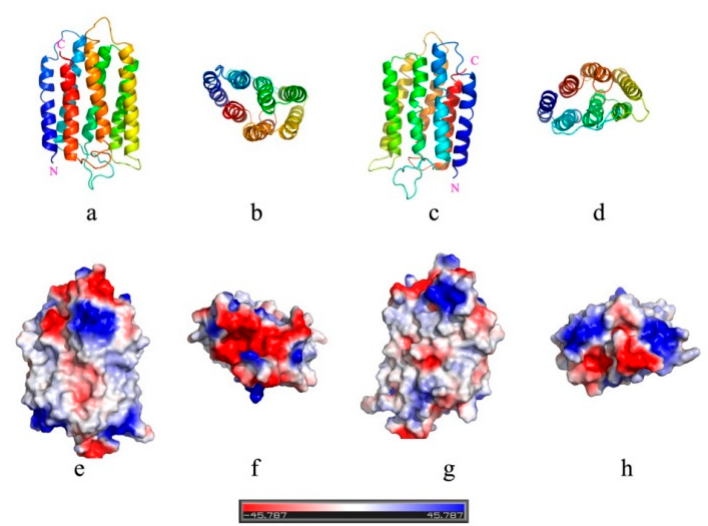
Figure 6. Structural and electrostatic properties of bR (PDB code: 1AP9). ( a – d ) Ribbon representations of the crystal structure from different views. ( e – h ) Electrostatic surface potential calculated with the aid of the Protein Continuum Electrostatics tool. b and f are the top views with the C terminus pointing upwards, whereas d and h are those viewing form the N terminus.